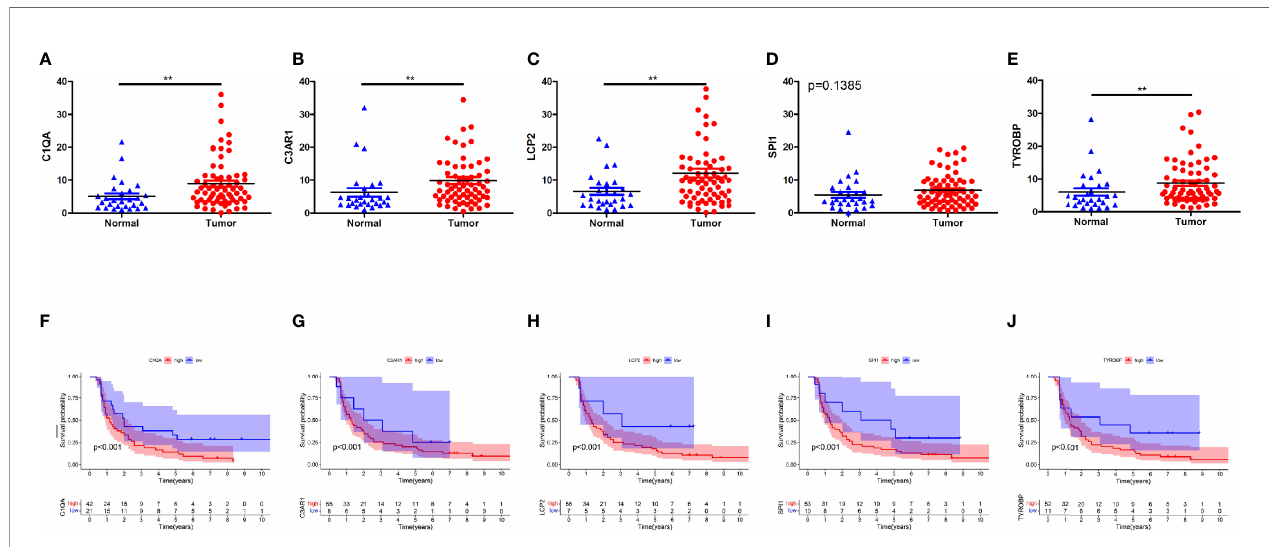
FIGURE 10 | Five genes validation using qRT-PCR for ESCC cDNA microarray chip. (A – E) Expression levels of C1QA, C3AR1, LCP2, SPI1, TYROBP were up- regulated in tumor tissues. (F – J) The expression of C1QA, C3AR1, LCP2, SPI1, TYROBP were correlated with poor outcomes of ESCC patients. (p<0.001). **p <